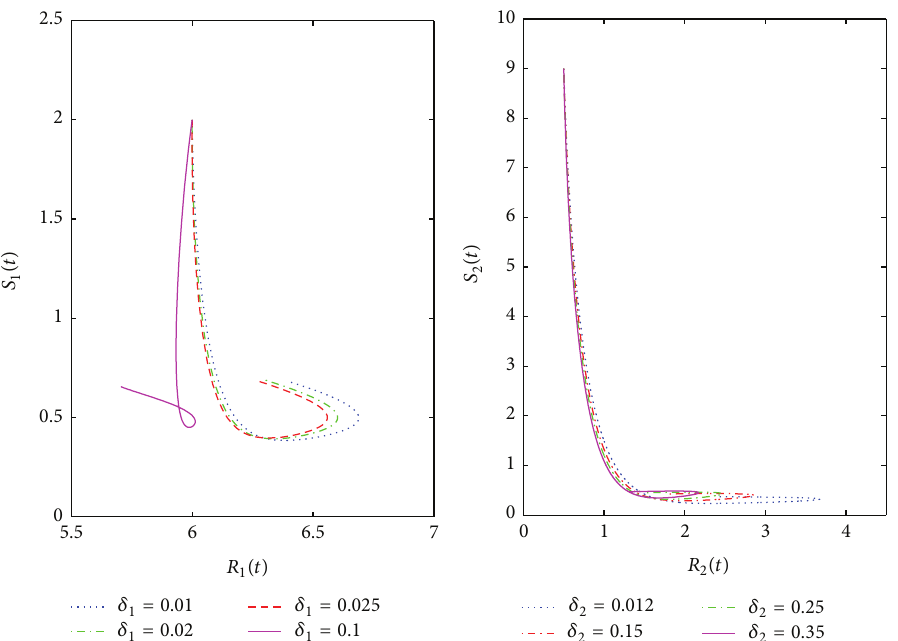
Figure 7: Comparison of relationships of 𝑆 𝑘 and 𝑅 𝑘 for the different values 𝛿 𝑘 in the deterministic SIRS